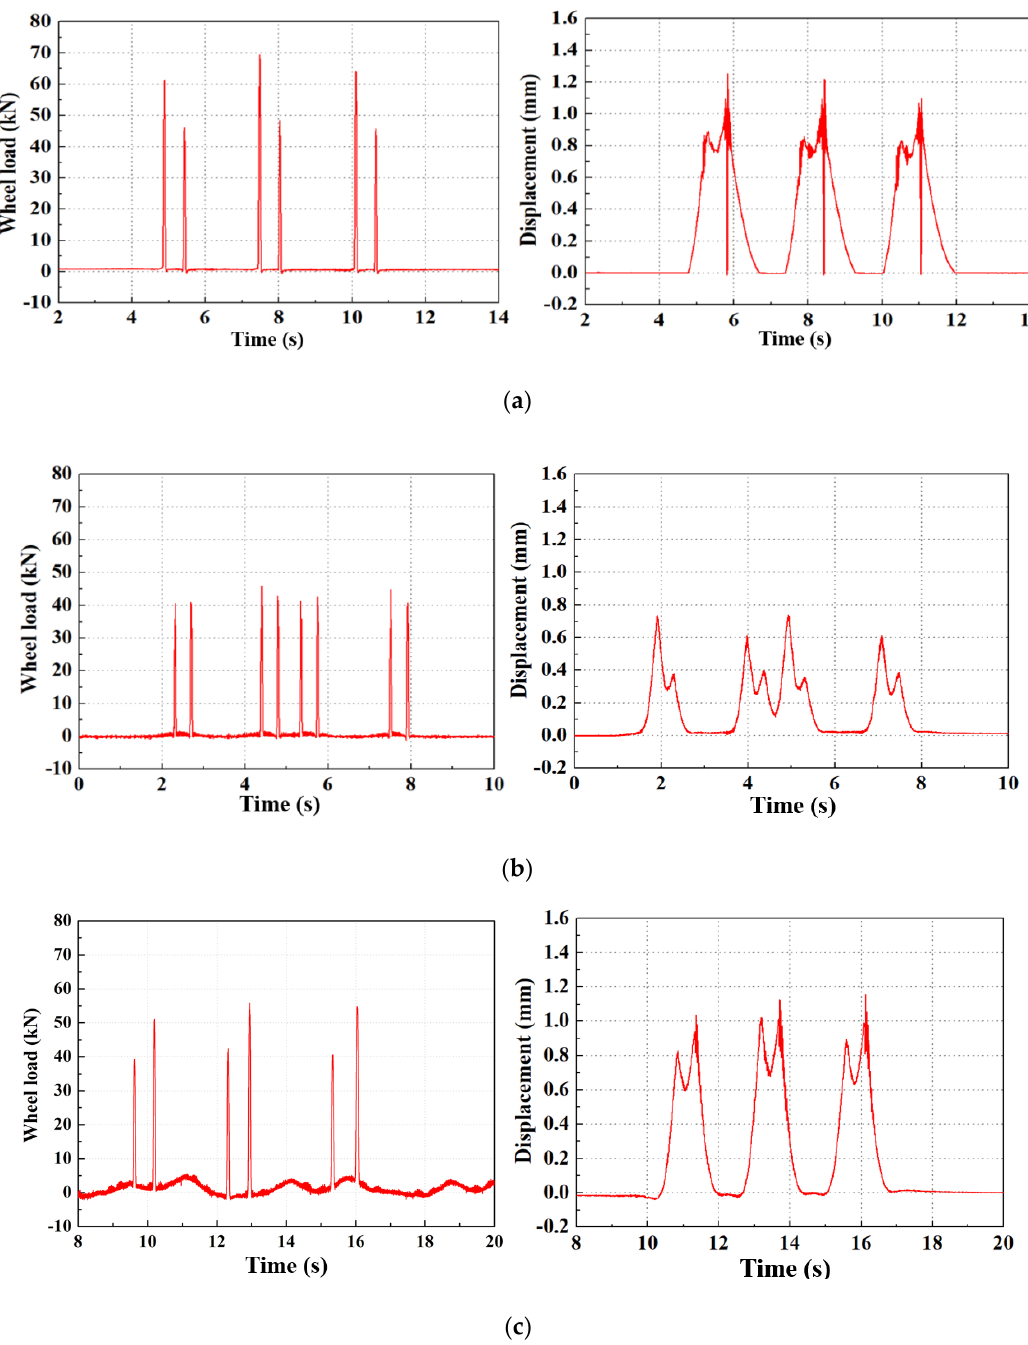
Figure 4. Examples of the measured dynamic wheel load and vertical rail displacement. ( a ) Section A; ( b ) section B; and ( c ) section C.